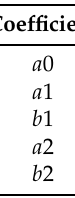
Table 2. Fourier series coefficients computed after data fitting.